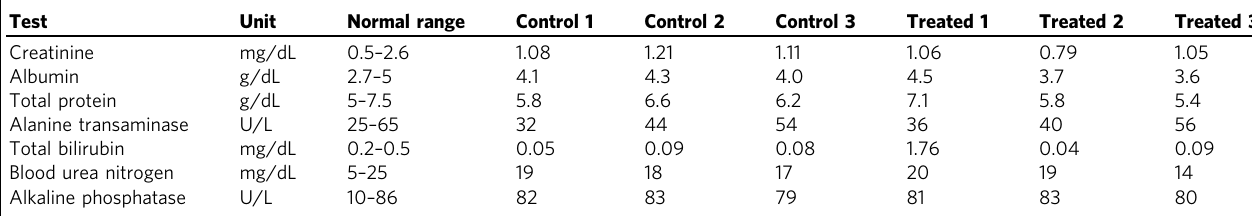
Table 1 Liver and kidney function tests in